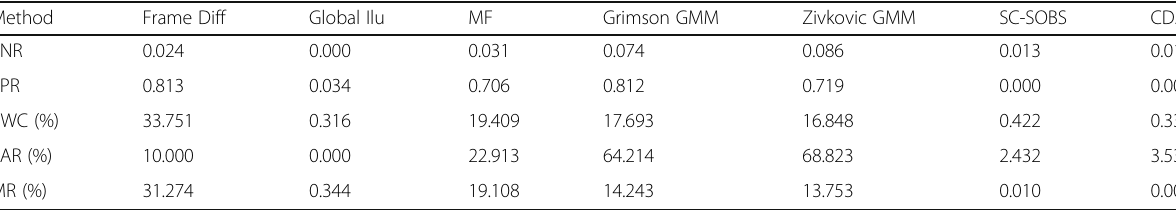
Table 2 Comparison results with the hand-labeled dataset Method Frame Diff